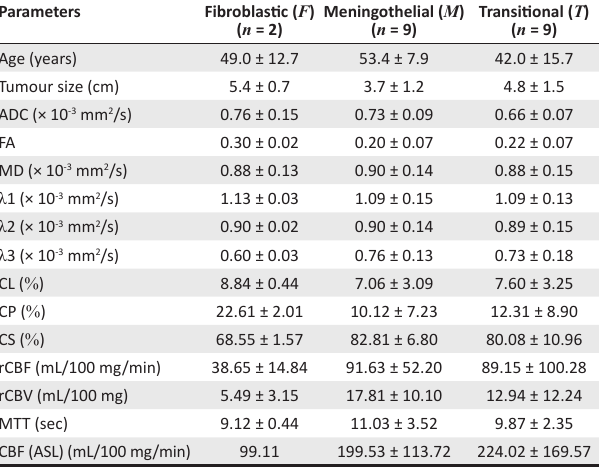
TABLE 2: Subtypes of typical meningiomas. Parameters